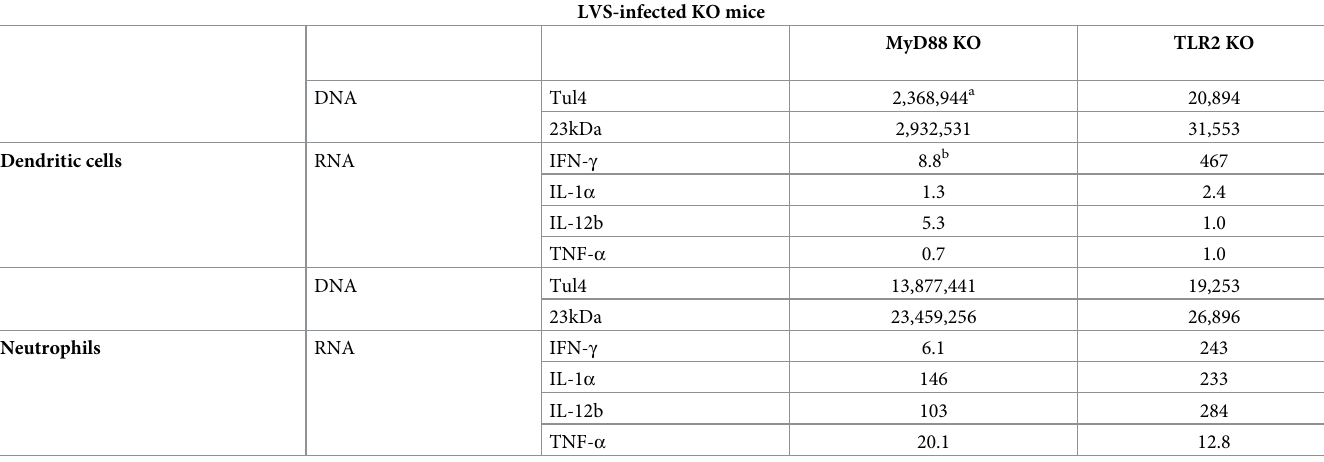
Table 2. Dendritic cells and neutrophils from MyD88 KO mice are highly infected with LVS but produce little IFN- γ .